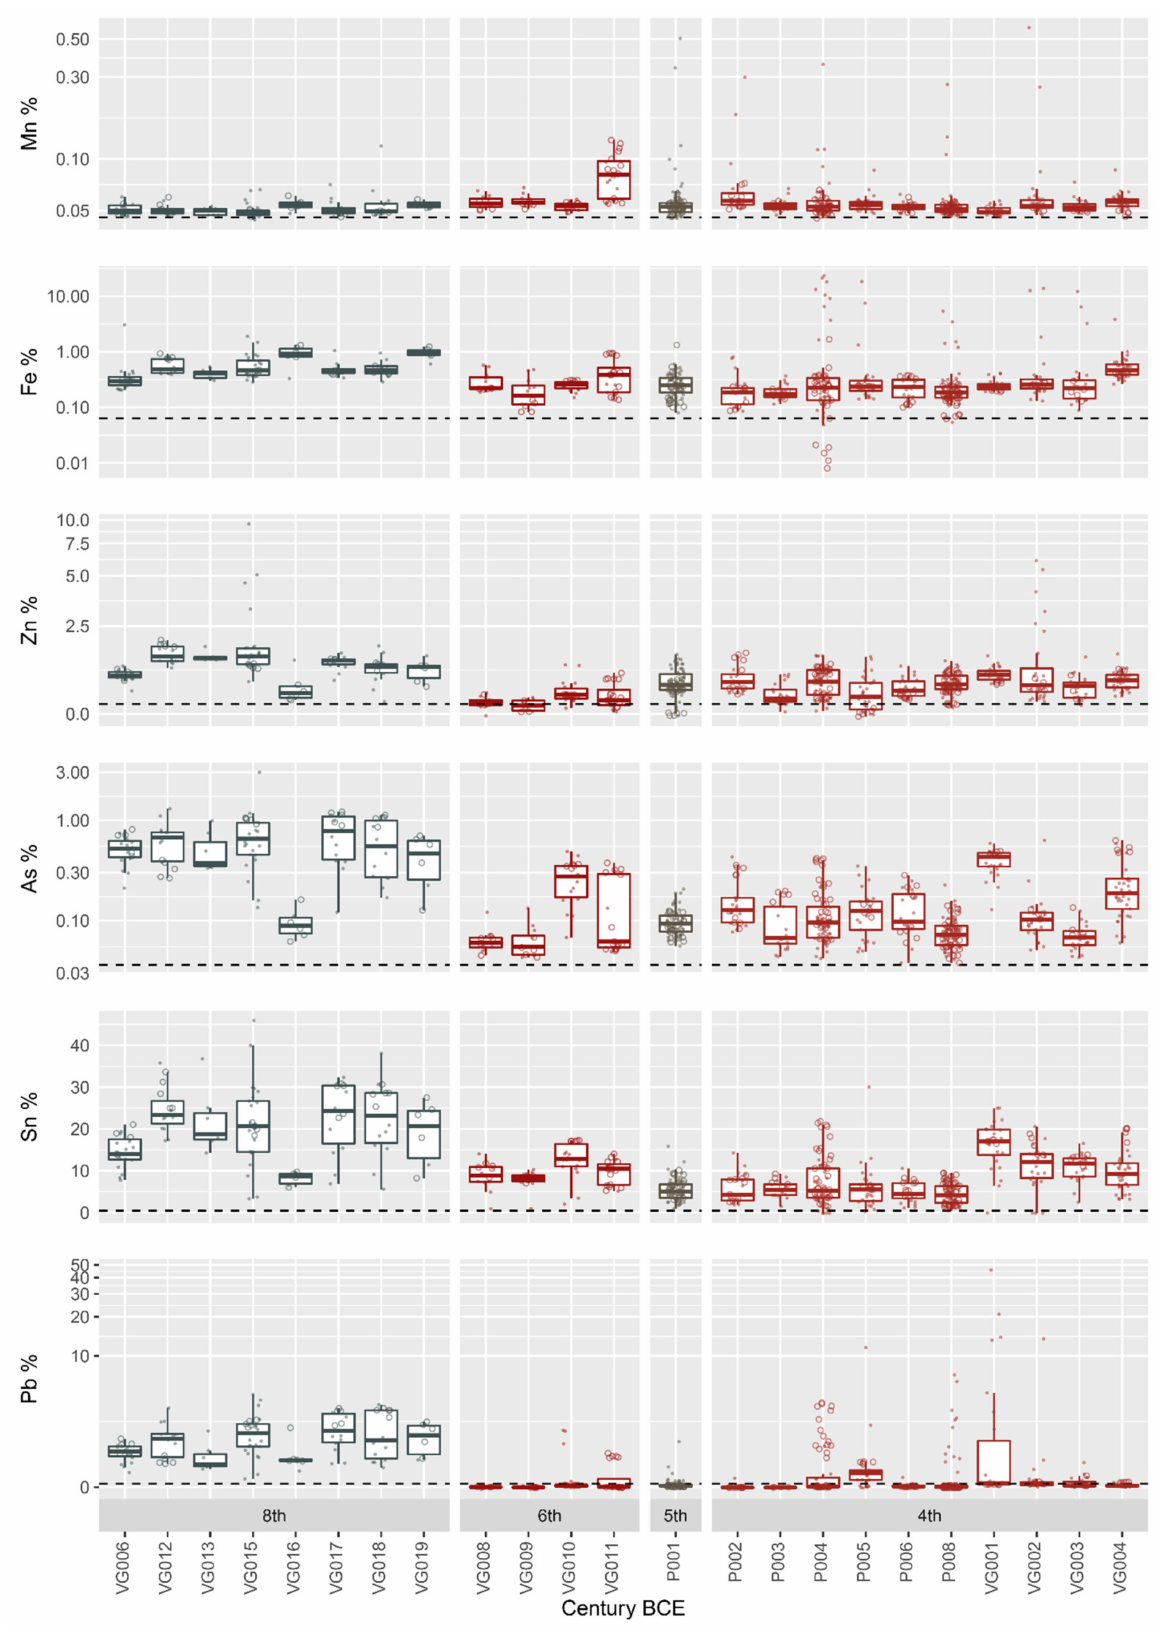
Figure 6. Box-plots of elements organised by century BCE. assay. Dashed lines indicate the limits of